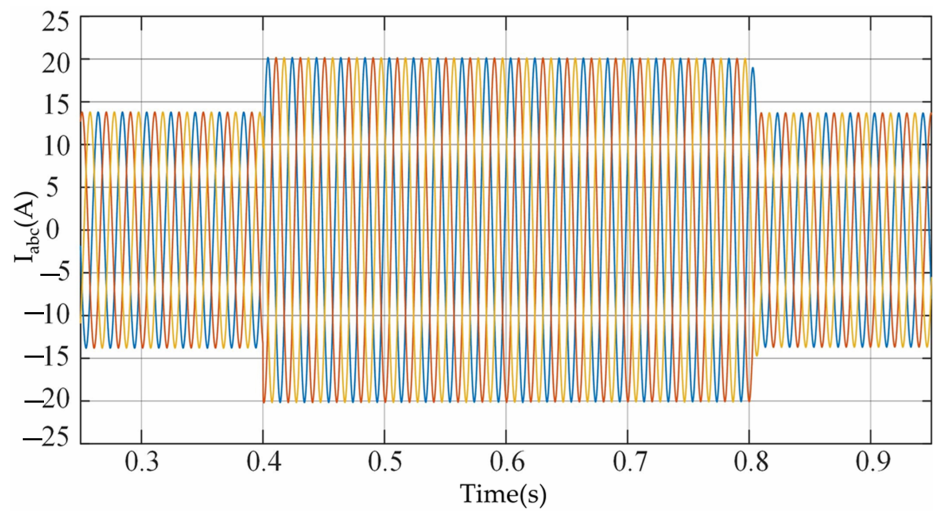
Figure 8. Variation of three-phase current in